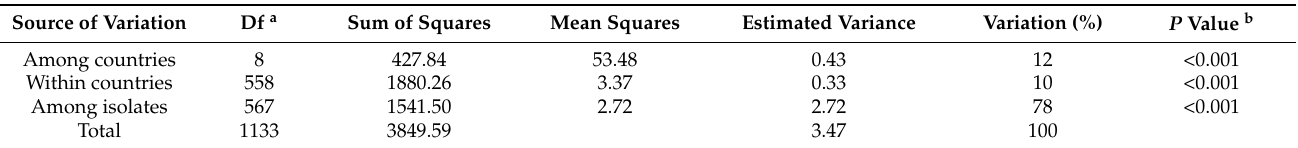
Table 4. Analysis of molecular variance for partitioning the variation in Puccinia striiformis f. sp. tritici isolates from nine countries. Source of Variation Mean Squares